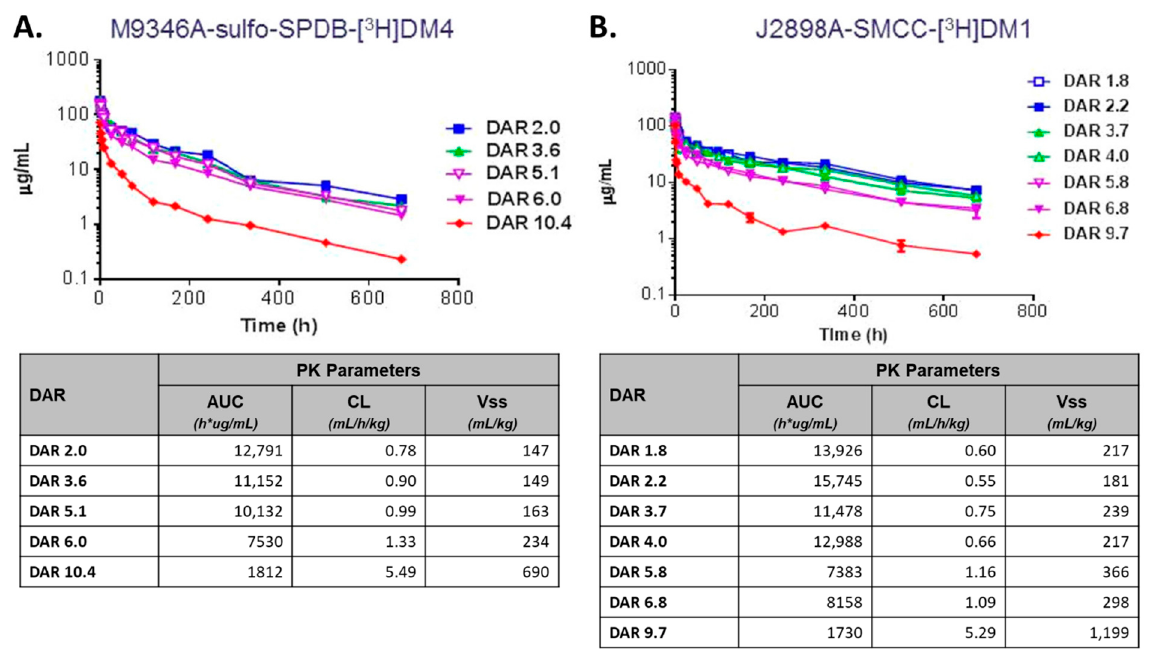
Figure 2. Pharmacokinetic studies evaluating ADC concentrations using radiolabeled ADCs. Clearance of M9346A–sulfo- SPDB–[3H]DM4 ( A ) and J2898A–SMCC–[3H]DM1 ( B ) conjugates from plasma of CD-1 mice. All agents were injected iv as a single 10 mg/kg dose. Concentrations of total ADC were measured by counting the radioactivity in plasma arising from the tritium label on the maytansinoid. These findings suggest that maytansinoid conjugates, regardless of linker type, with drug–antibody ratios (DAR) ranging from 2 to 6, have a better therapeutic index than conjugates with very higher DAR (>9). Reproduced and altered with permission from Sun et al. Bioconjug. Chem. 2017, 28, 1371–1381